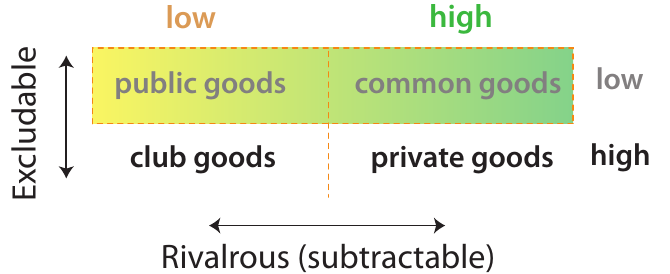
Figure 4. Typology of goods according to degree of excludability and rivalry (subtractability)